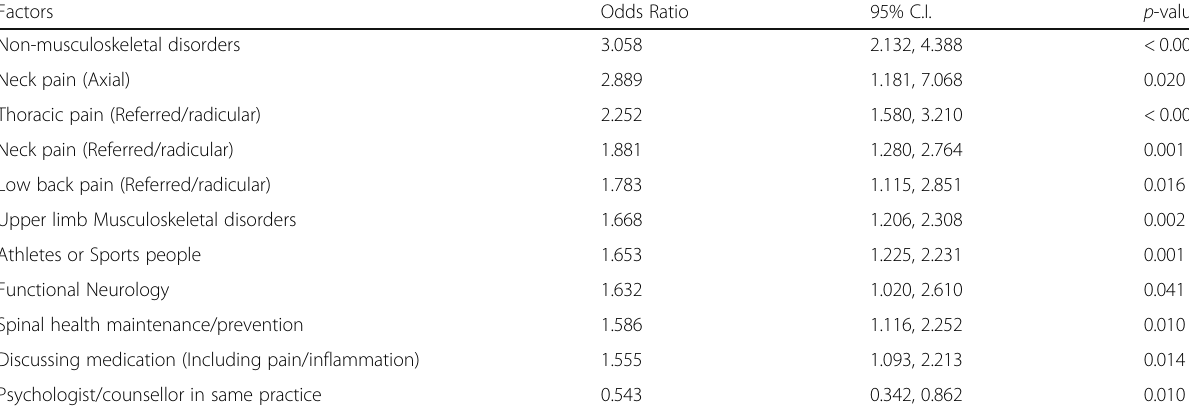
Table 4 Logistic regression output for chiropractors that treat migraine often compared to never/rarely/sometimes